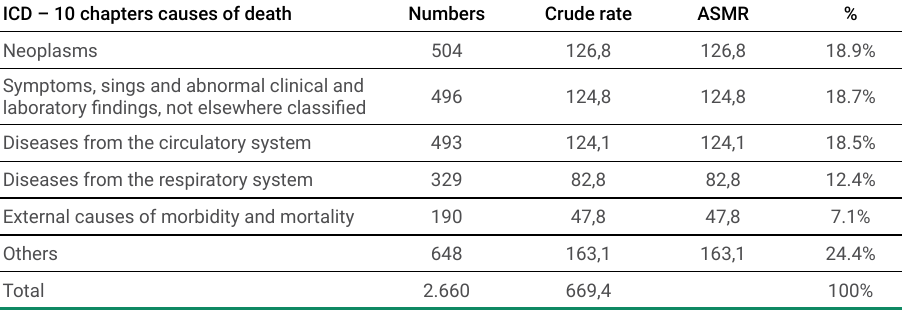
Table 3. Causes of death in the city of Piracicaba according to ICD - 10 chapters.